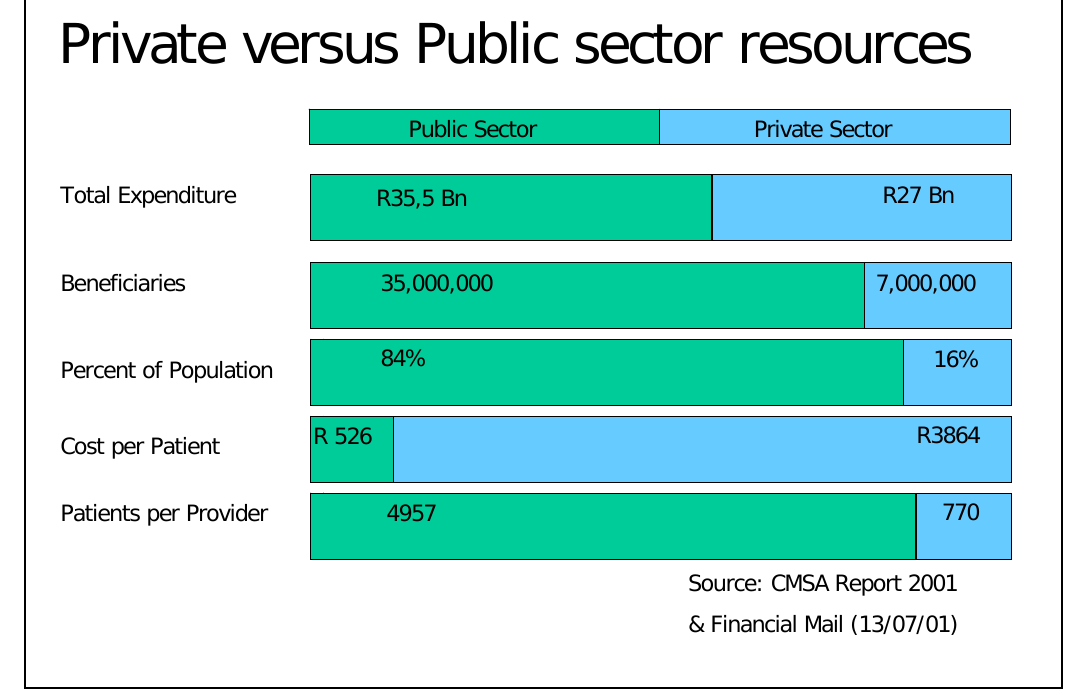
Figure 1: Public versus private sector spending